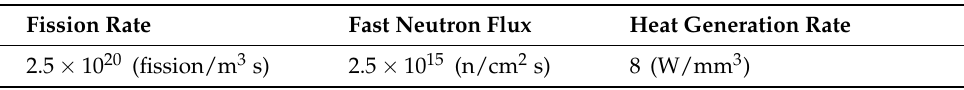
Table 1. For FE simulations, loading conditions such as the fission rate, fast neutron flux, and heat generation rate of fuel particles are